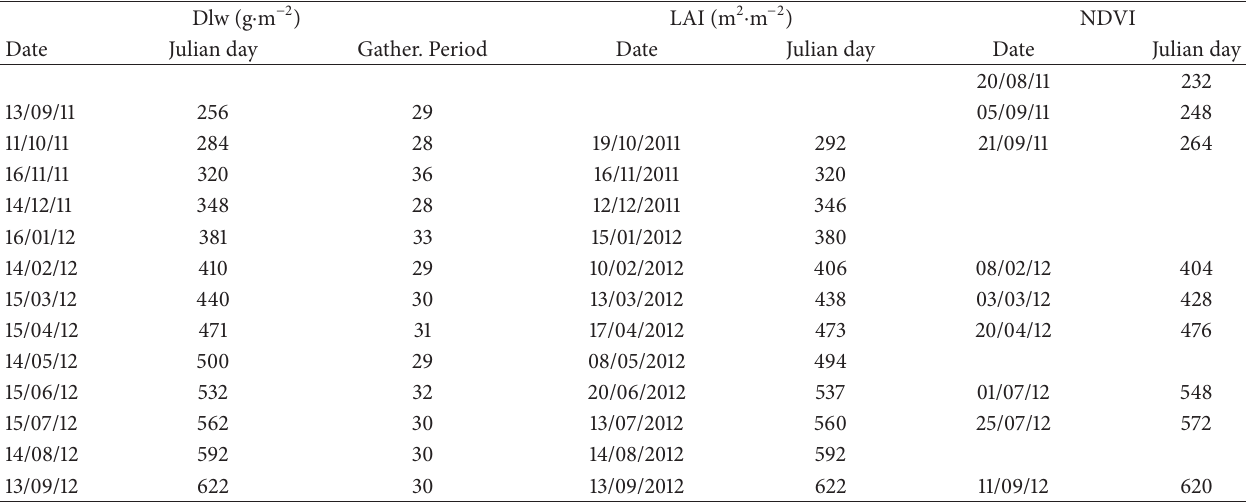
Table 2: Collection dates of the Litterfall, LAI measurement, and Landsat 5 images (08/20/11–09/21/11) and IRS (08/02/12–09/11/12), and respective days of the period